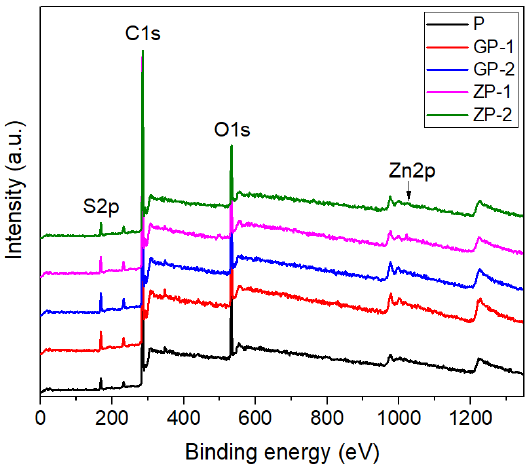
Figure 6. XPS spectra of fabricated membranes. Table 3. Element composition of fabricated membranes obtained from XPS data.